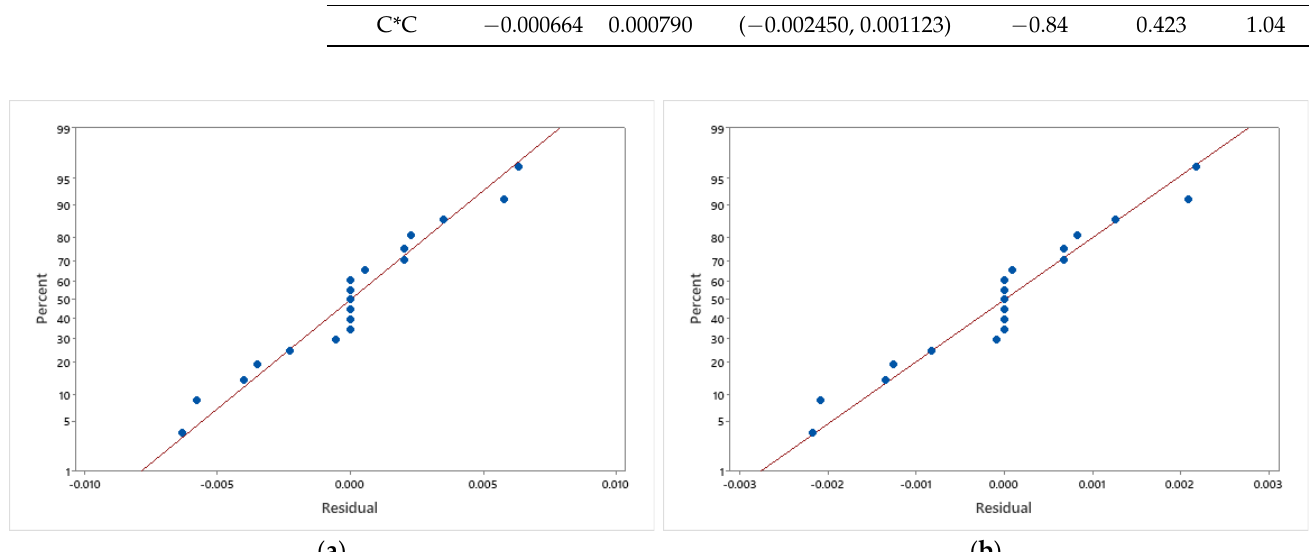
Figure 8. The residual normal plot for ( a ) Re 1/2